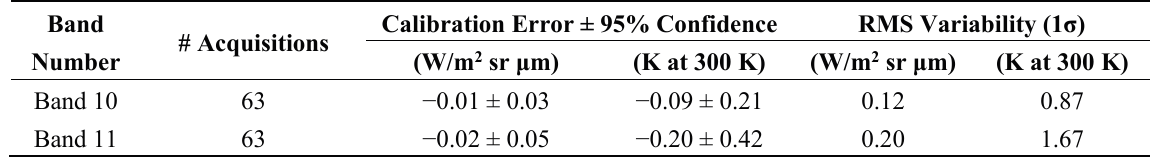
Table 4. Current TIRS calibration status, the residual bias error and the RMS variability for the day data after all vicarious calibration imagery was reprocessed with the corrected calibration